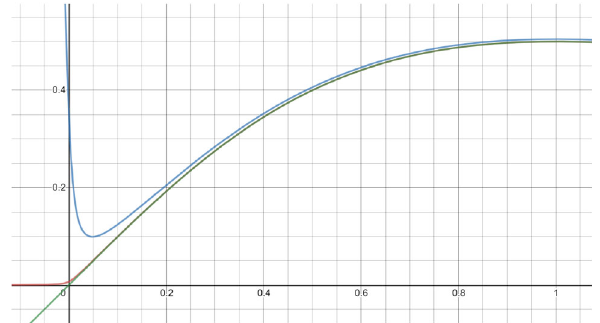
Fig. 1 The superradiance limit ω sl and the upper limit ω max − ex almost coincide in the range 0 < α < 1. The modified value of superradiance ω (cid:6) exceeds the upper limit ω max − ex . (Here we let M = sl